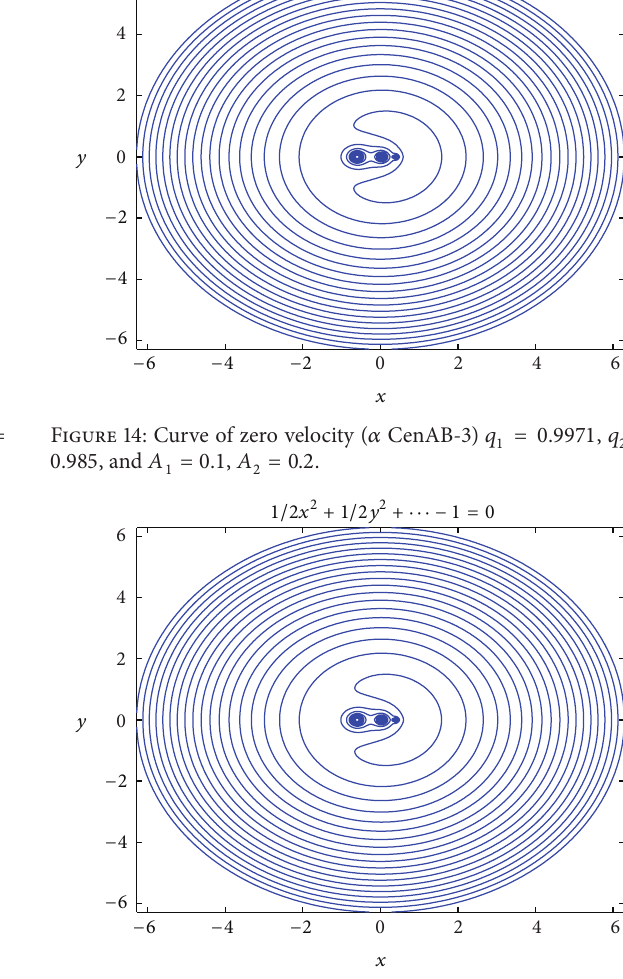
Figure 12: Curve of zero velocity ( 𝛼 CenAB-1) 𝑞 1 = 0.9971 , 𝑞 2 = = 0 , 𝐴 = 0 . 0.985 , and 𝐴 1 2